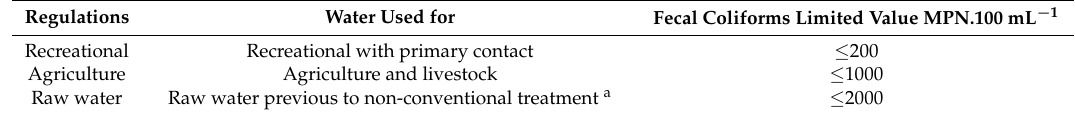
Table 1. Ecuadorian Water Quality Regulation for fecal coliforms